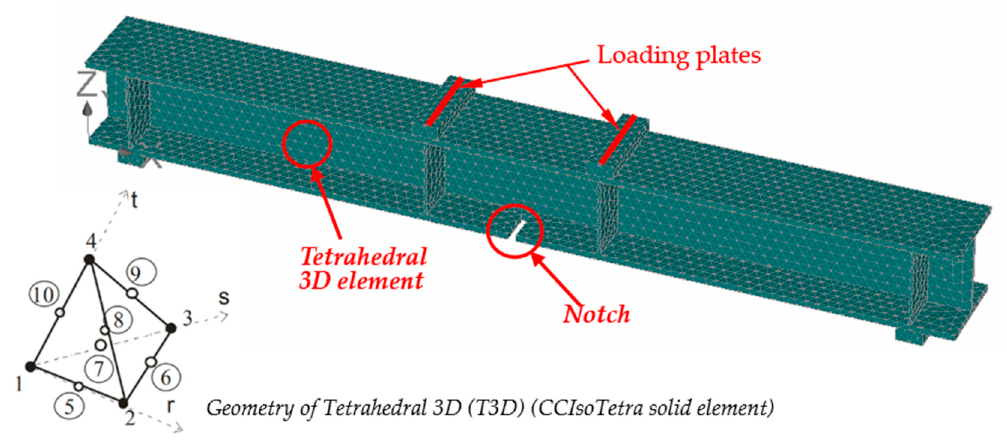
Figure 8. ATENA 3D FE model—mesh generation.